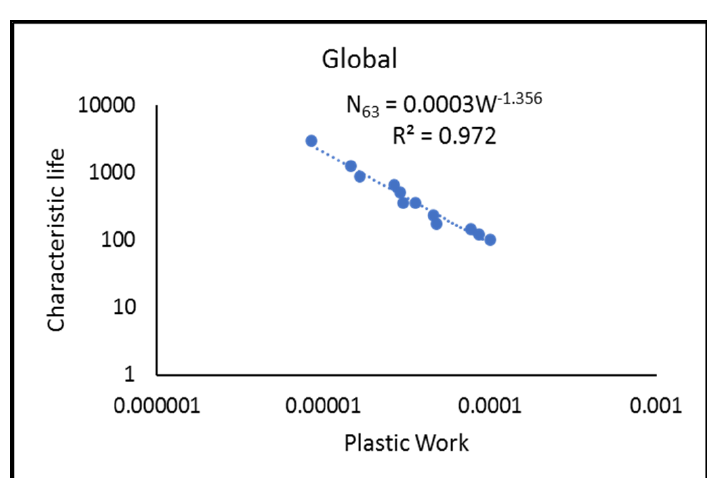
Figure 32. Characteristic life vs. inelastic work for SAC305 joints at various dwelling times on a log– log scale.